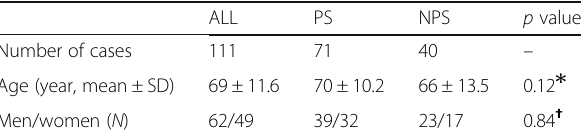
Table 1 Patient characteristics